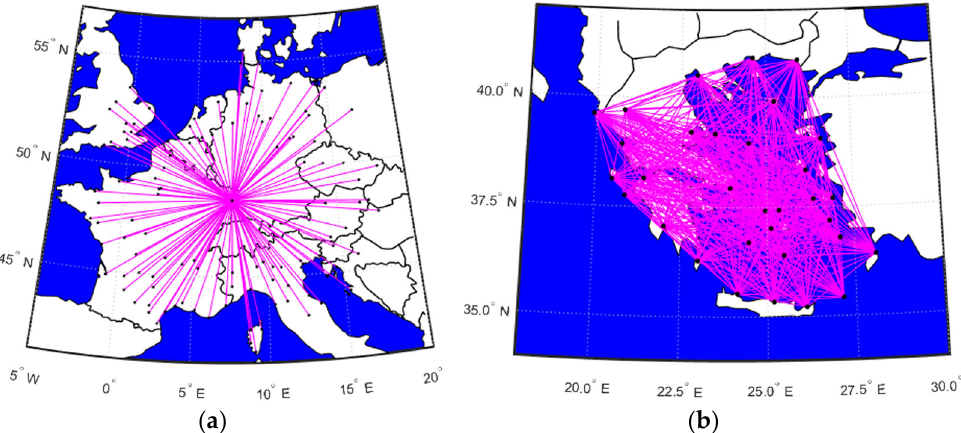
Figure 6. Example ( a ) Connections from Strasbourg (SXB) between 350–800 km, Example ( b ) Feasible domestic flight routes of Greece between 150–800 km.